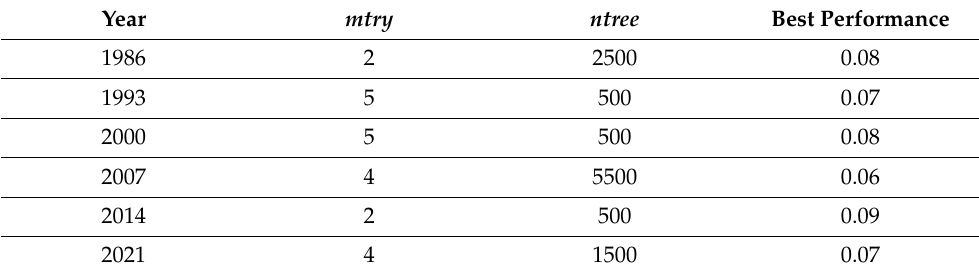
Table 4. The combination of mtry and ntree used to train the model for image